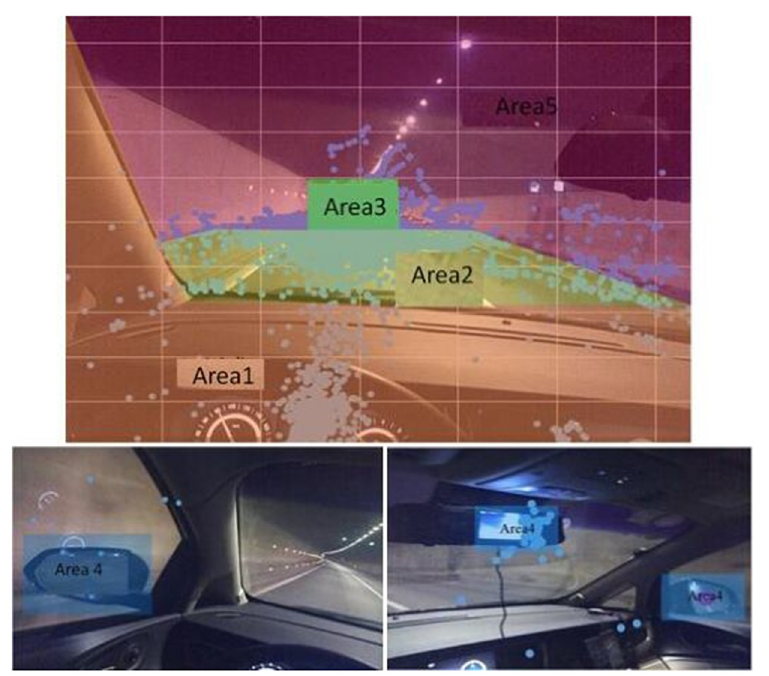
Fig 7. Diagram of fixation area division from the driver’s